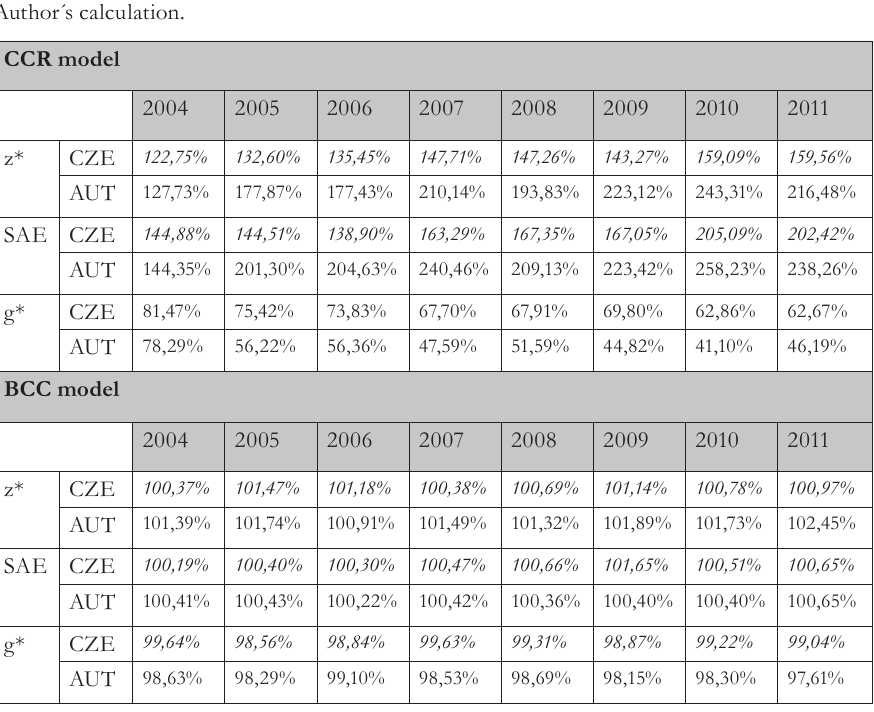
Tab. 2 – Efficiency level measured by CCR and BCC model with undesirable output. Source: Author´s